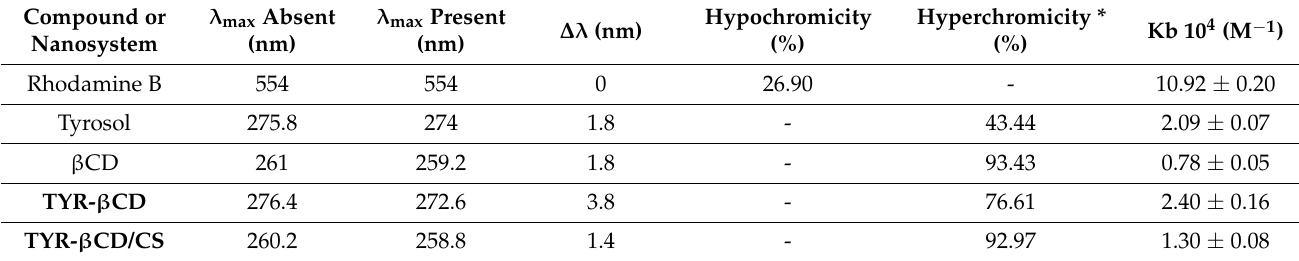
Table 9. UV-Vis absorption data for rhodamine B, tyrosol and nanosystems in the absence and presence of ctDNA. Compound or